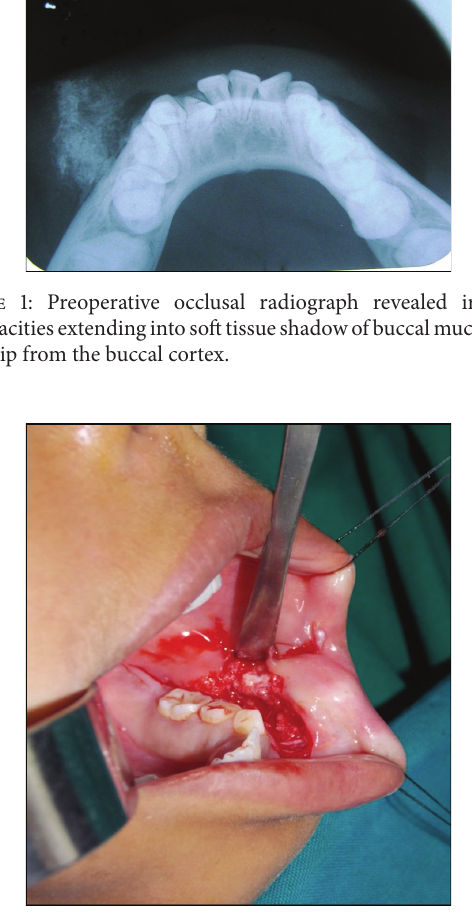
Figure 2: Intraoperative picture showing exposure of bony mass.